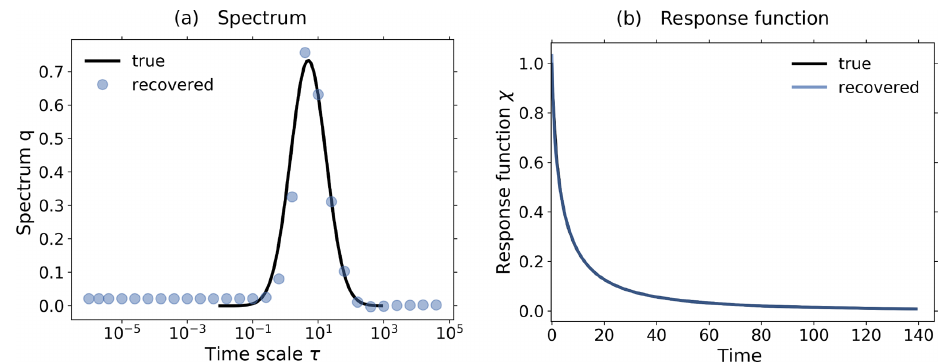
Figure E11. Response function χ(t) and spectrum q λ recovered from toy model data taking the RFI parameters M = 30, log τ min = − 7, and log τ max = 5. Blue dots in (a) and blue line in (b) indicate the recovered values for the spectrum and for the response function, while black lines indicate their “true”